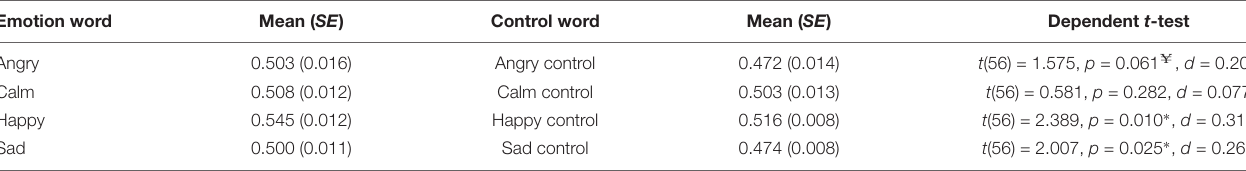
TABLE 1 | Predominance ratios for each of the four emotion categories and respective controls for Experiment 1. Emotion word